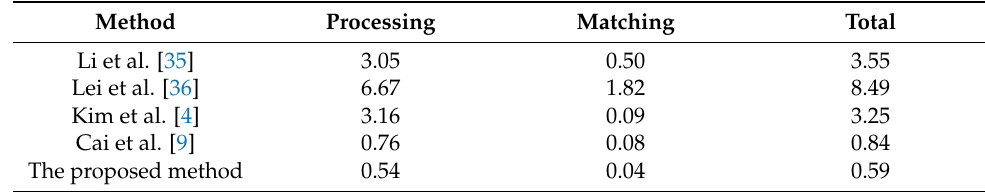
Table 5. Comparison of computation time (s) of the processing and matching.